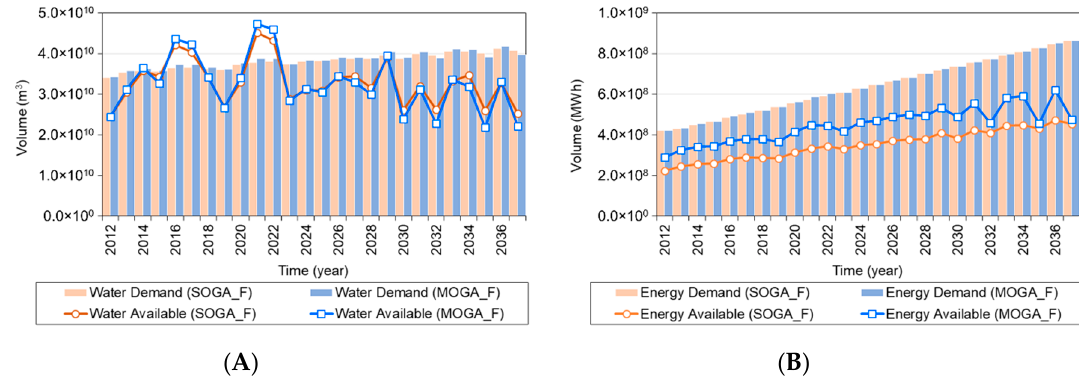
Figure 6. Comparison of SOGA and MOGA solutions maximizing URI_F for availability and demand of ( A ) water and ( B ) energy sectors. Table 1. Optimal solutions from single-objective genetic algorithm (SOGA) and multi-objective